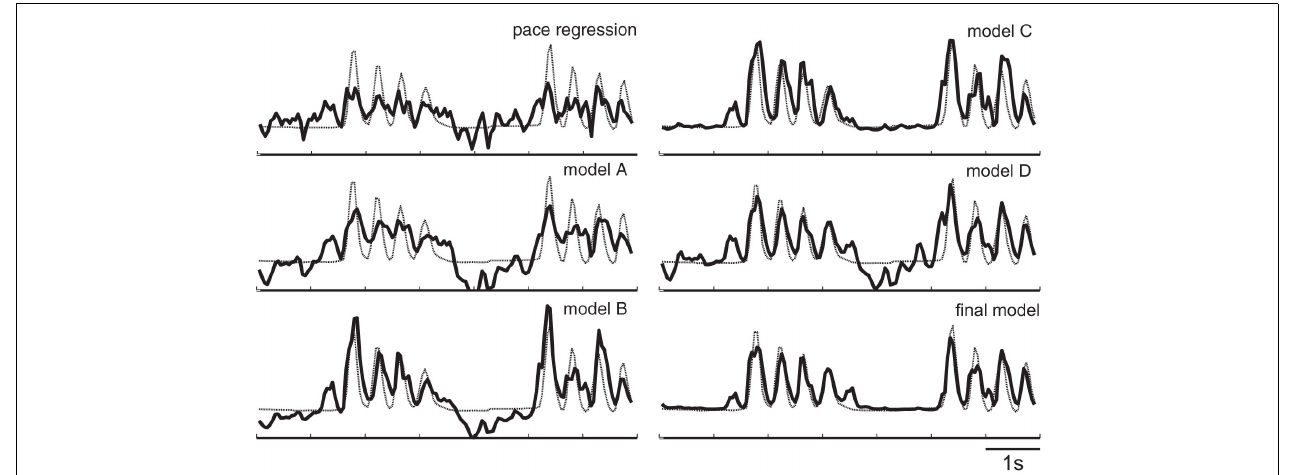
FIGURE 11 | Exemplary decoding results of the models in Figure 10.